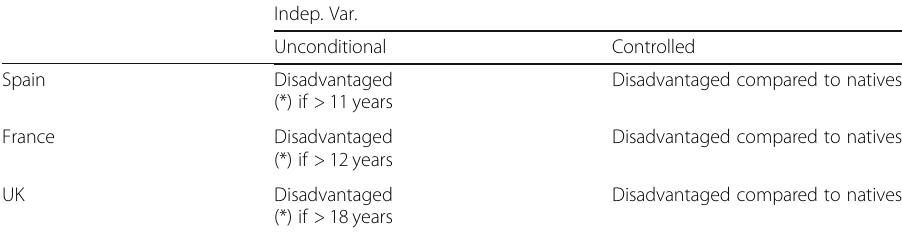
Table 2 Summary of the effects on high skilled (with tertiary education) migration unemployment across destination